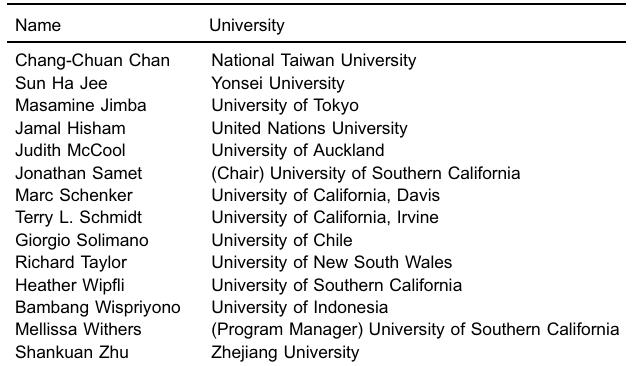
Table 5. 2015 workshop